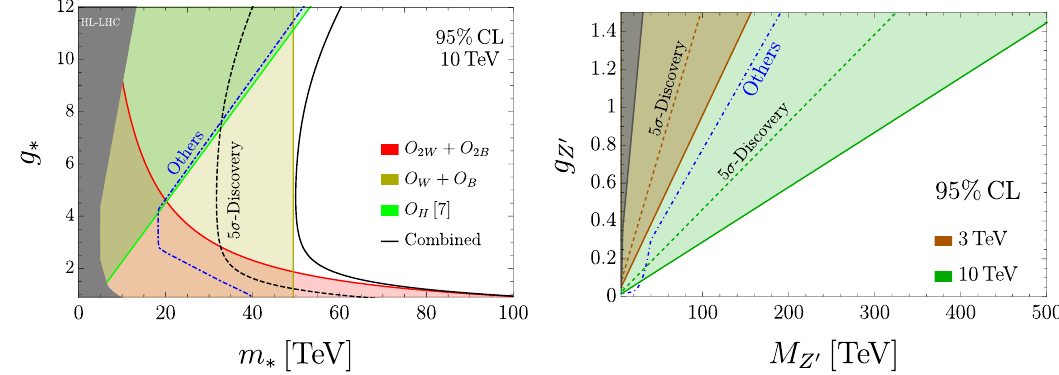
Figure 10. Left Panel: 95% exclusion reach on the Composite Higgs coupling-mass parameter space. The reach for O is taken from [7]. Right Panel: sensitivity projections for a Y -universal H Z 0 model. The gray band and the blue dash-dot line represent respectively the region probed by the HL-LHC program and the sensitivity projections for all other future collider projects